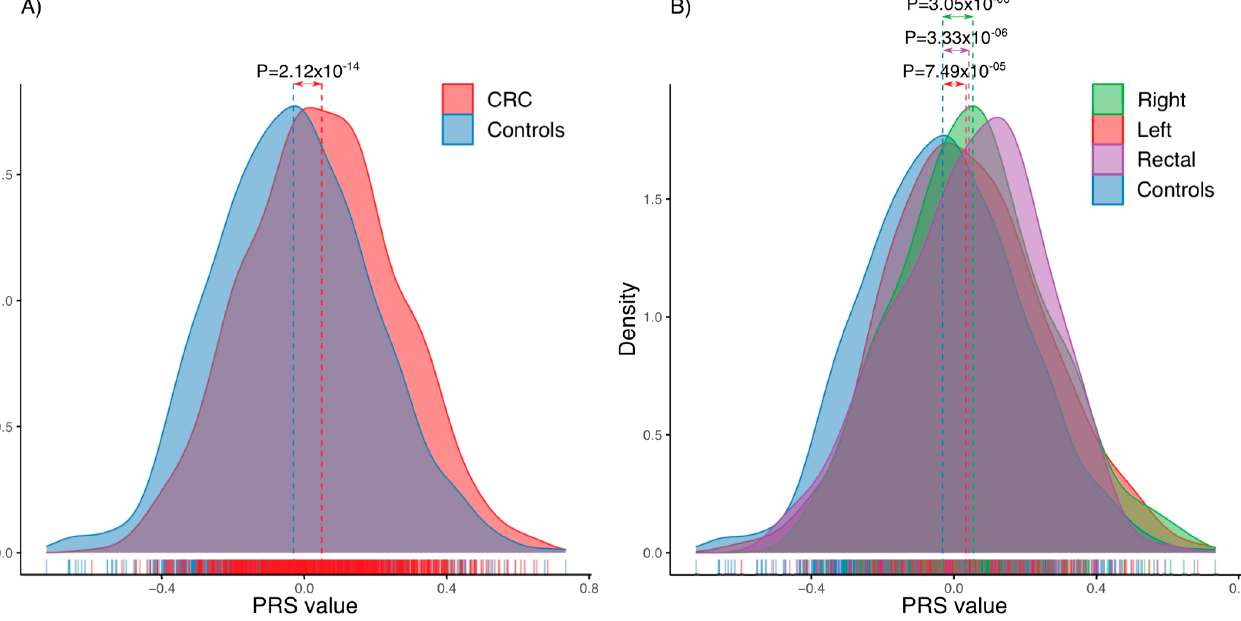
Figure 3. Distribution of polygenic risk score based on PGS000785 set. P, the p -value of the T-test. ( A ) Colorectal cancer. ( B ) According to the location. ( C ) Comparison with patients with irritable bowel disease. ( D ) Comparison with patients of main types of irritable bowel disease. 4. Discussion The development of colorectal cancer (CRC) is influenced by environmental factors [4], microbiome composition [5] and genetic factors. In this work, we have analyzed the contribution of the genetic component to CRC risk in the Basque population, a population with a particular genetic history. That particular genetic history was reflected in the prin- cipal component analysis and, as it was done before [19], adjusting for PCs is enough to avoid artifacts due to the presence of two ancestries in the population.